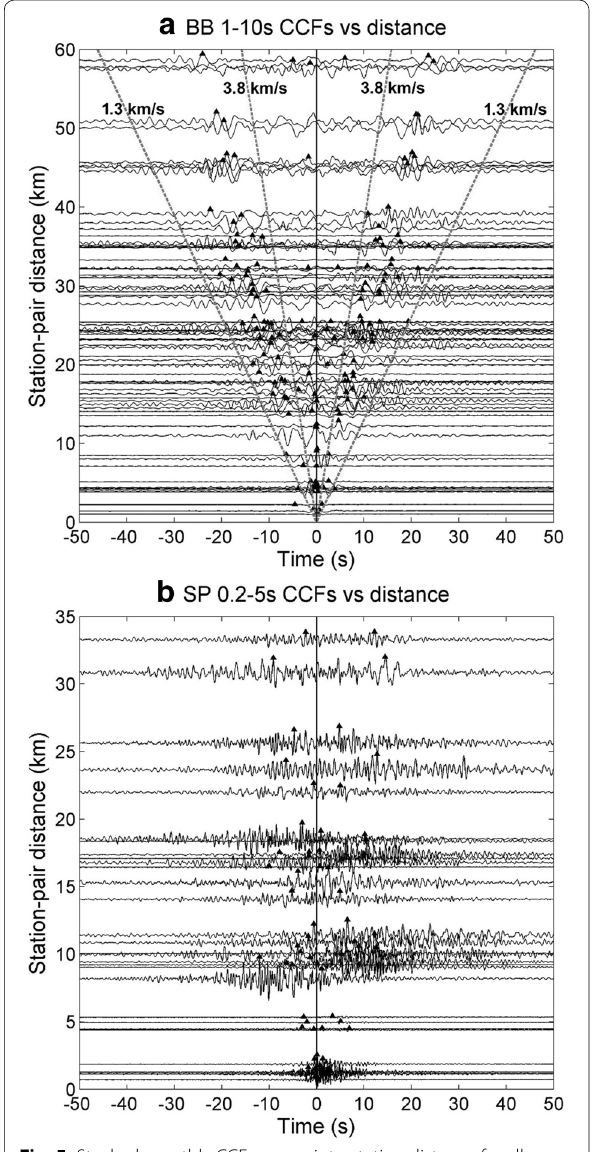
Fig. 5 Stacked monthly CCFs versus interstation distance for all station pairs: a 1–10‑s BB station pairs demonstrate the propagation of main Rayleigh‑wave signals with an apparent velocity window of 1.3–3.8 km/s (gray dashed lines); b 0.2–5‑s SP station pairs demonstrate Rayleigh‑wave signals without a distinct velocity window. Black triangles mark the maximum amplitude of CCFs on the positive‑time and negative‑time axes